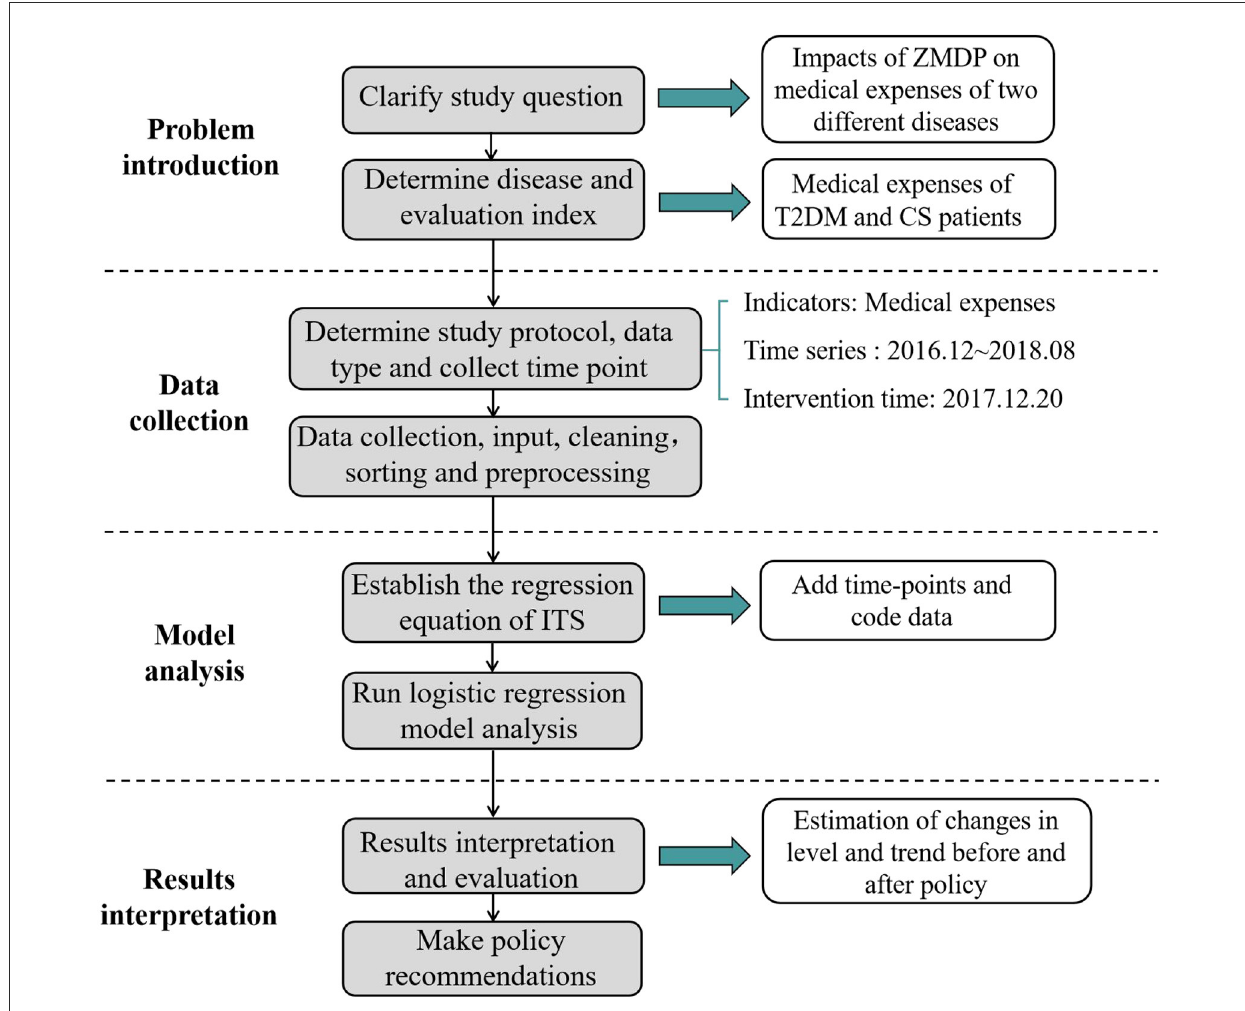
FIGURE1 Flowchart of ITS analysis of medical expenses for two